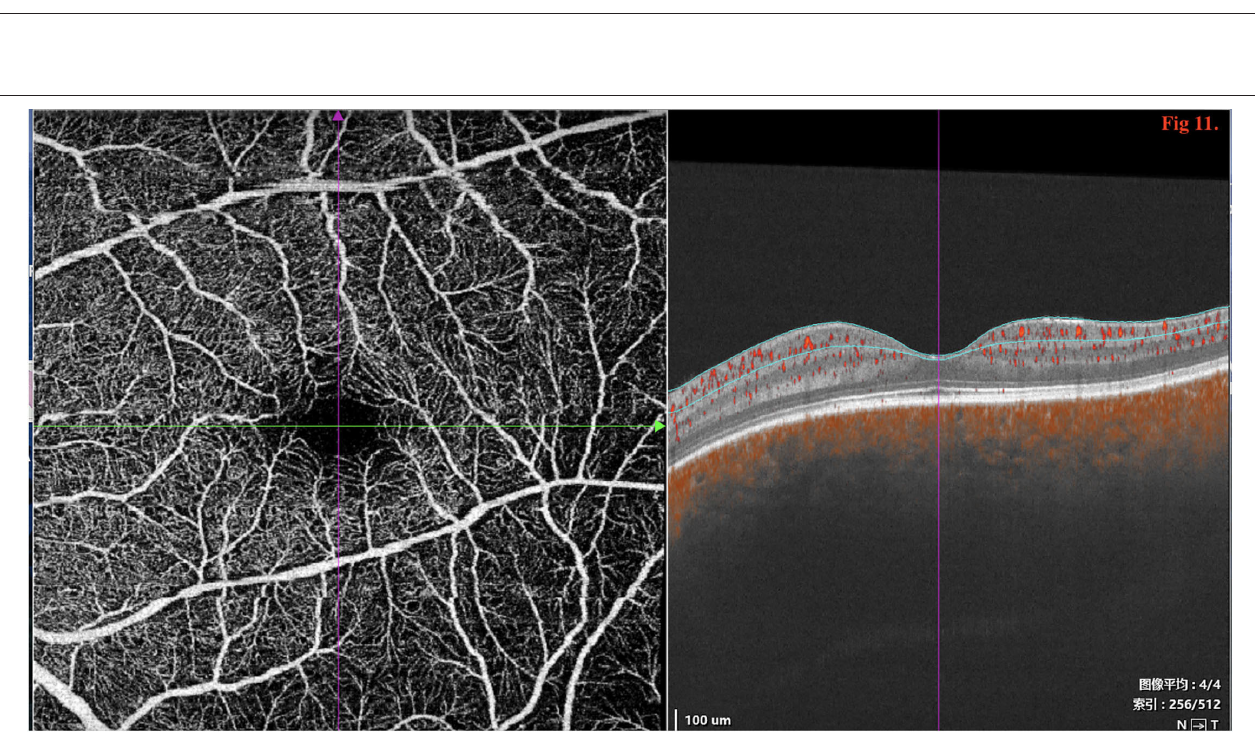
FIGURE 11 | SD/SS-OCTA (SS-OCT, VG200D, SVision Imaging, Ltd., China) revealed that the macular morphology was normal with no decrease in the size of foveal avascular zone (FAZ).